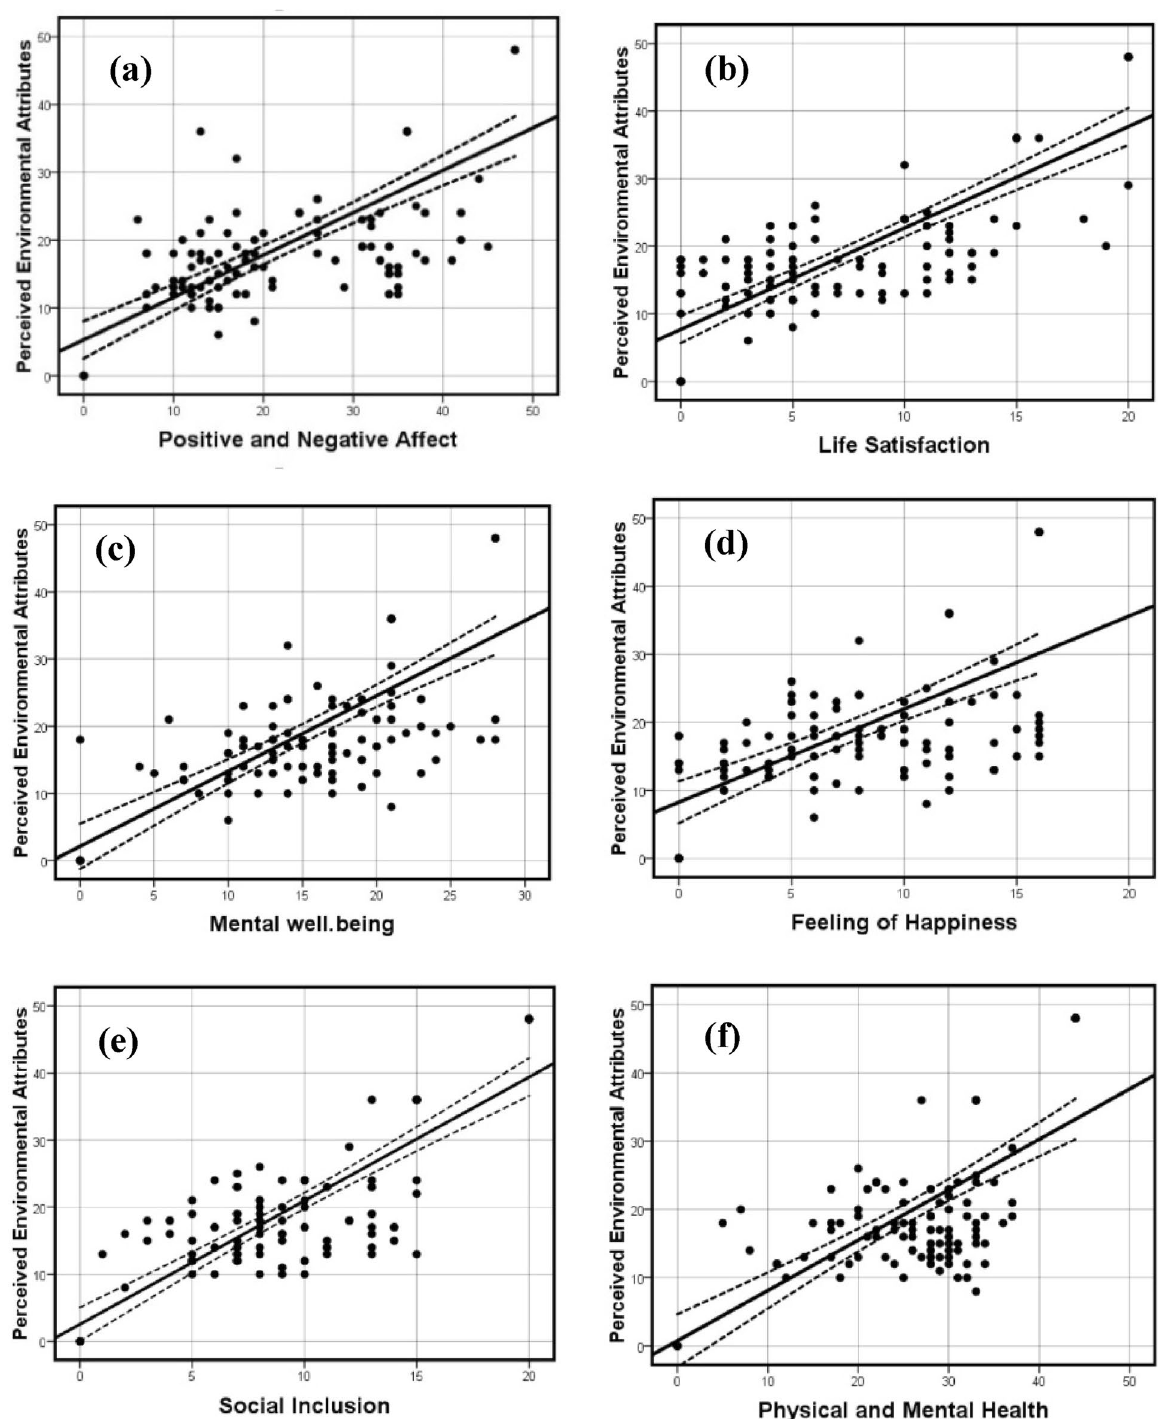
Figure 4. The scatter graphs illustrating the correlation between perceived neighborhood environment characteristics and factors of citizens’ subjective